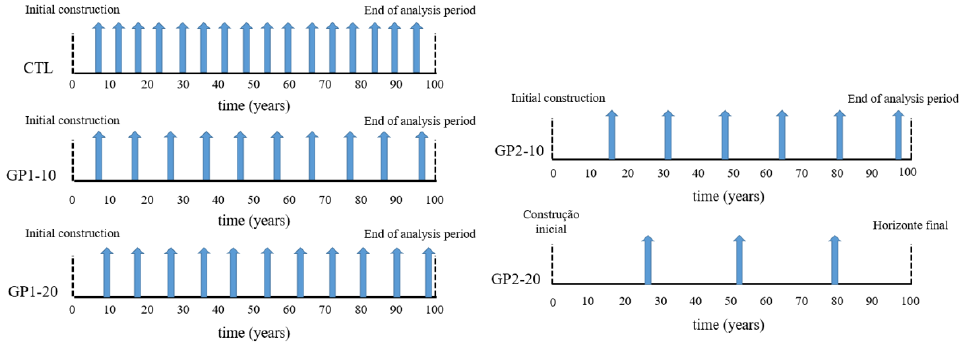
Figure 12. Repair necessity assessment for the 100-year period.